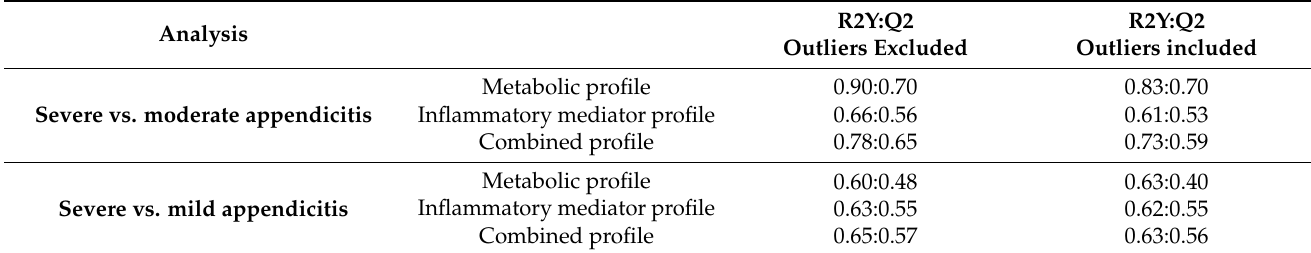
Table 3. Comparison of R2Y:Q2 values calculated for the OPLS-DA models with and without